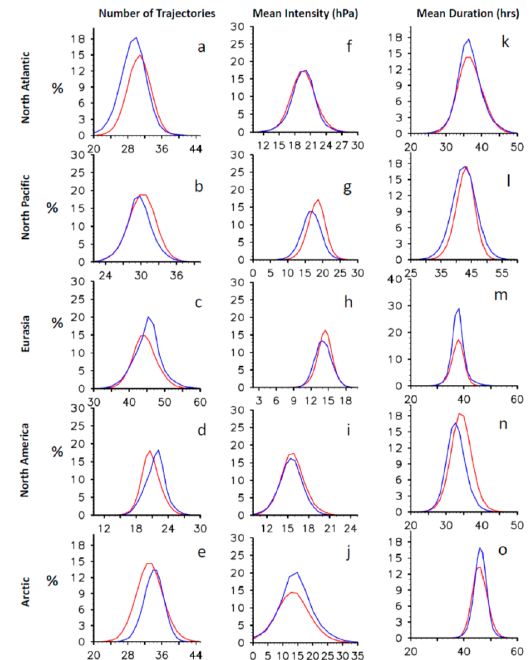
Figure 5. Probability Density Function (PDF) of mean number of storm trajectories ( a – e ), mean intensity ( f – j ) and mean duration ( k – o ) for each of the sub-regions (Figure 2). Red lines for Pos (more sea ice years) and blue line for Neg (less sea ice years).